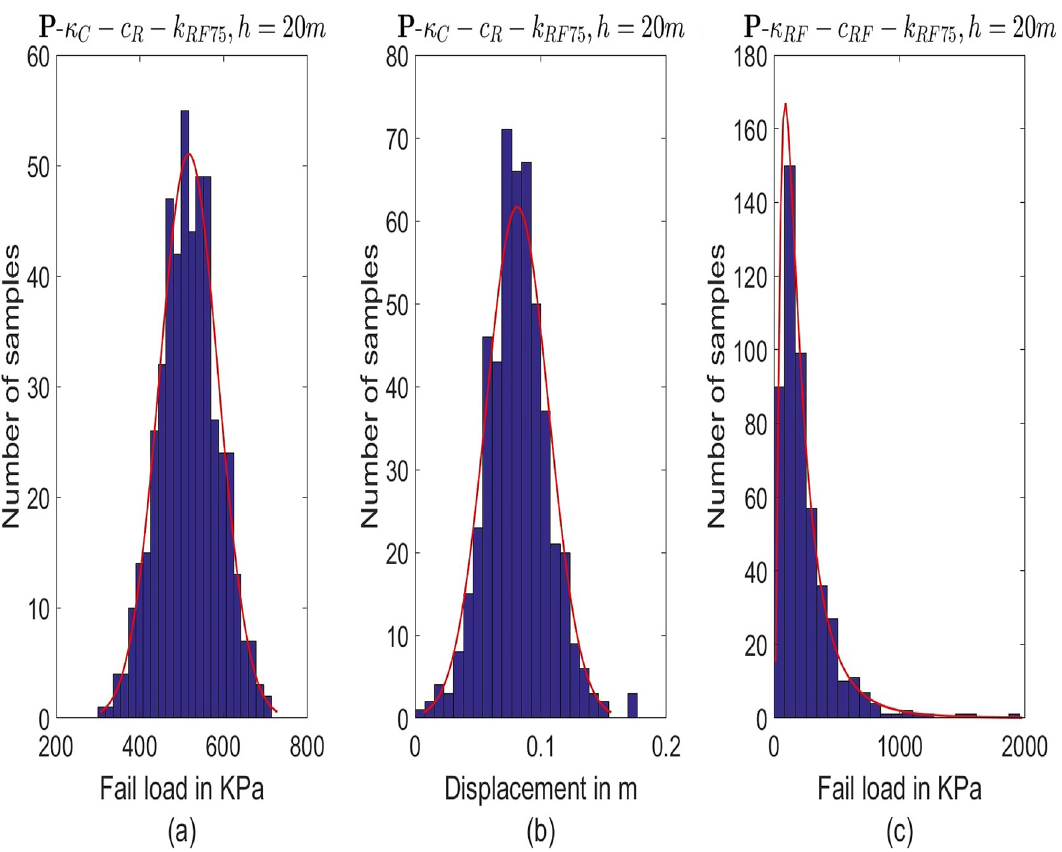
variable the failure load. b Same as a and monitored output varia- ble the failure displacement. (c) Porous analysis of depth 20 m with random field representations for all stochastic material variables and b = 75 m and monitored output